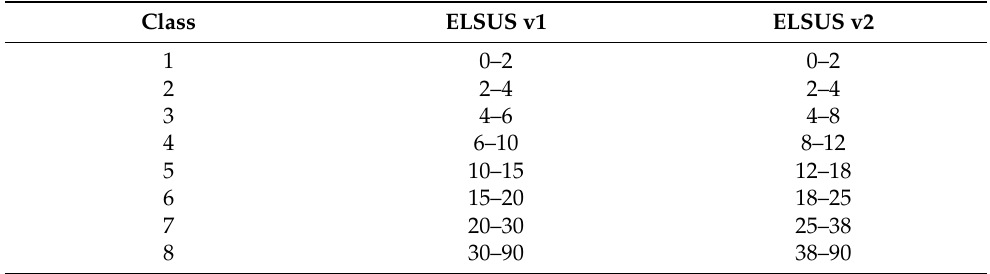
Table 2. ELSUS versions v1 and v2: slope classes (values in sexagesimal